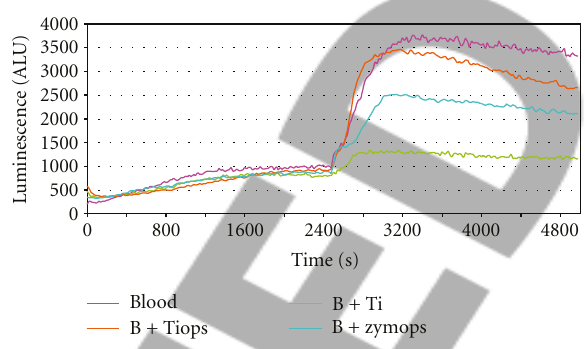
Figure 1: Chemiluminescence response of whole blood cells to Ti, opsonised and nonopsonised, and opsonised zymosan (positive control). Reaction mixture included whole blood cells without particulate materials (negative control) and in the presence of Ti, Tiops, and Zymops particles. Cells were stimulated with fMLP+PMA at 2400